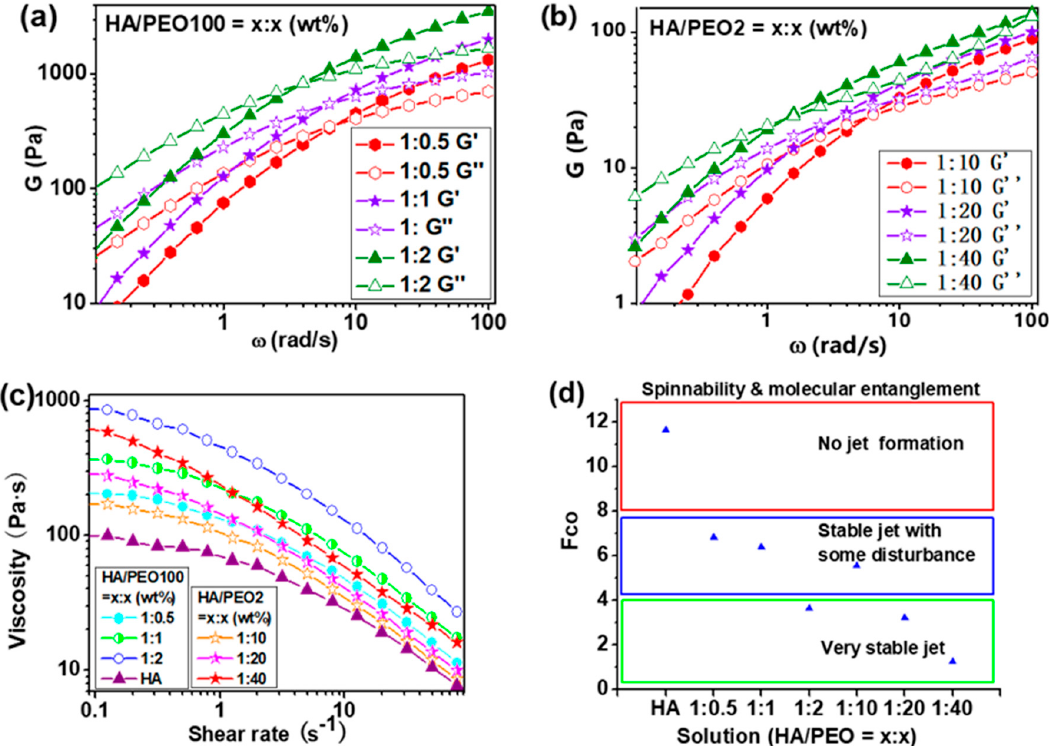
Figure 2. Rheological properties and shear viscosities of the HA / PEO blended solutions: G’ and G” of: ( a ) HA / PEO-100; and ( b ) HA / PEO-2 blended solutions. ( c ) Shear viscosities of HA and HA / PEO blended solutions as functions of the shear rate; and ( d ) F co versus electrospinnability. Table 1. Physical properties of the HA blended solutions and their electrospinnability. Sample